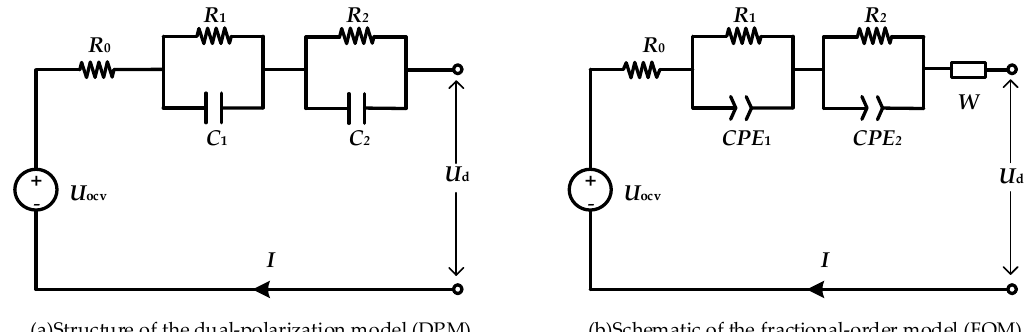
Figure 1. Structural diagram of equivalent circuit models (ECMs).